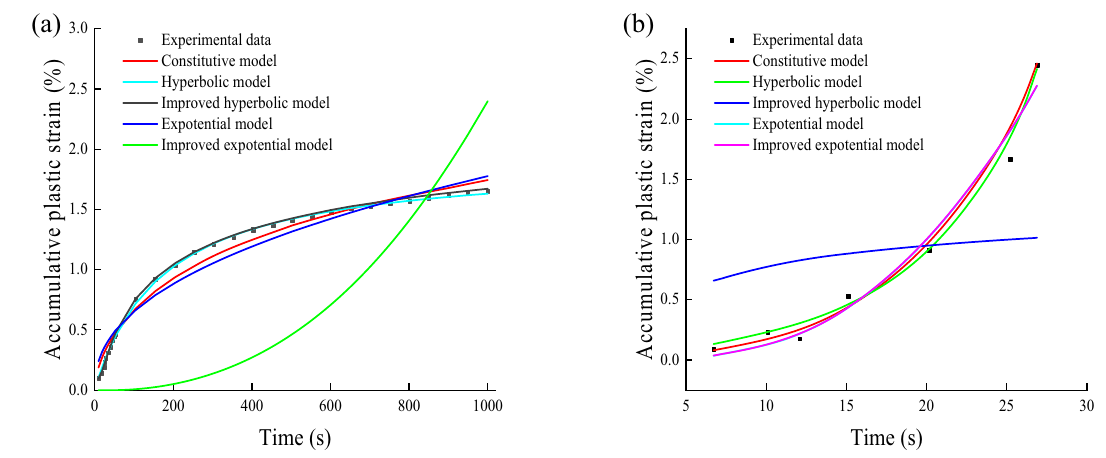
Figure 15. Comparison of fitting effects of different models: ( a ) CSR = 3; ( b ) CSR =